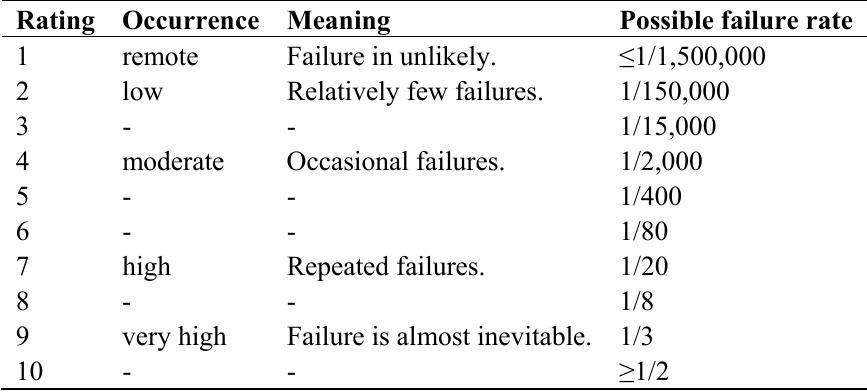
Table A1. FMEA ratings for occurrence of a failure ( O )